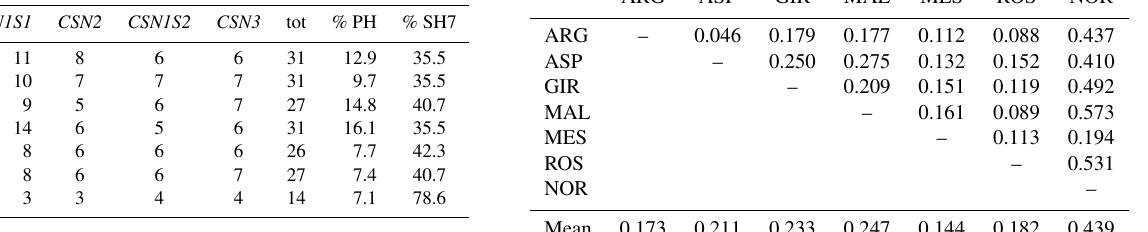
Table 5. Pairwise Nei’s genetic distance ( D s ) between the seven goat